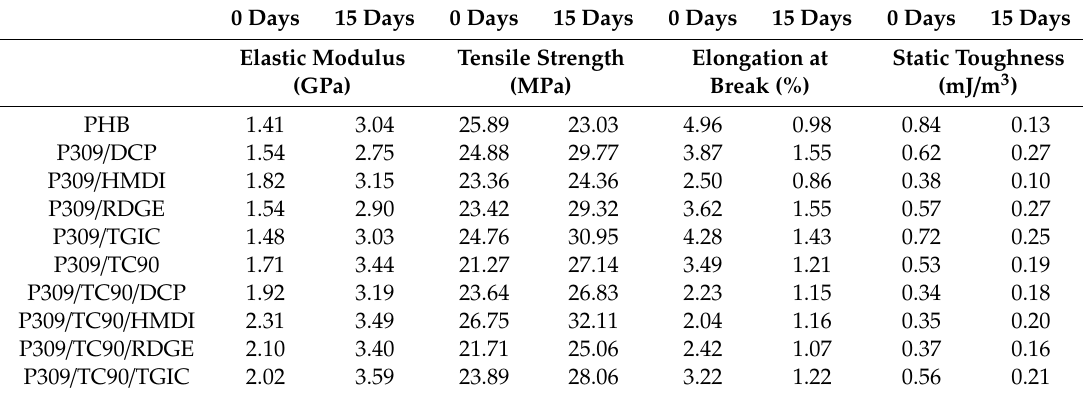
Table 3. Mechanical parameters corresponding to tensile